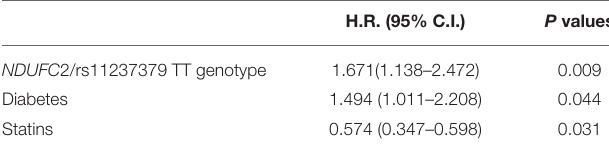
TABLE 4 | Predictors of ACS recurrence at follow-up by multivariate analysis. H.R. (95%